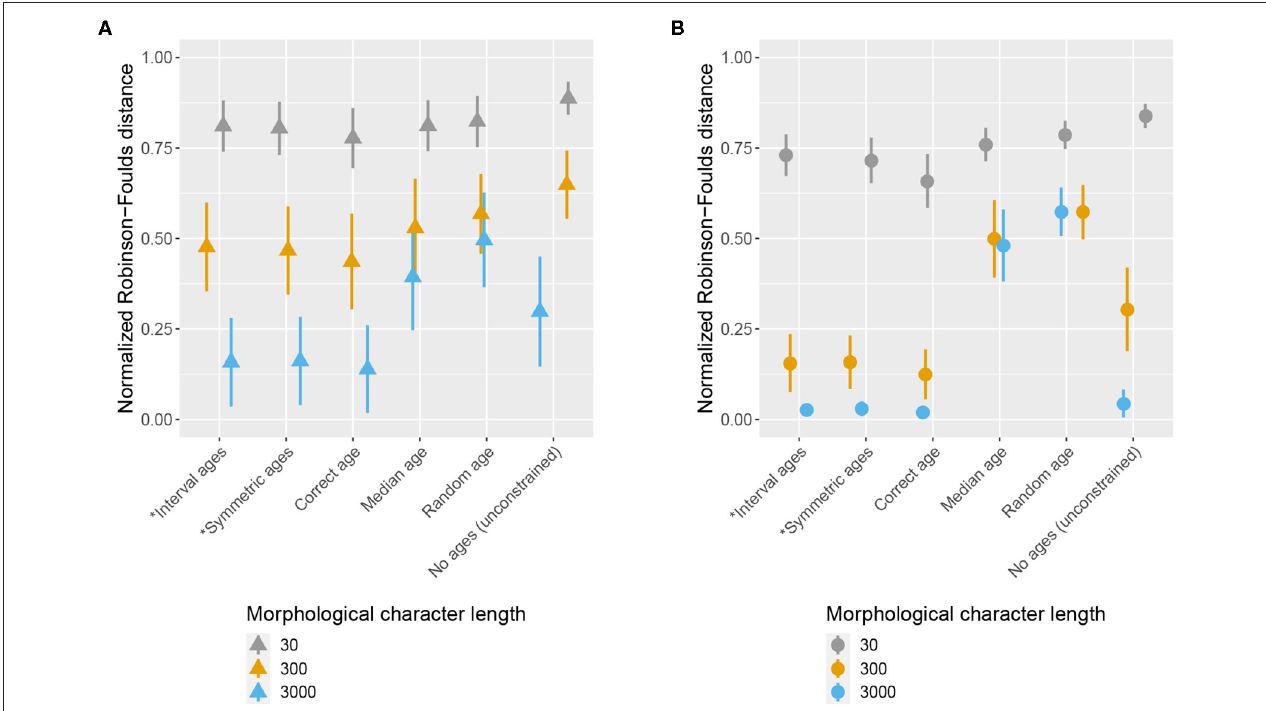
FIGURE 5 | Impact of character and fossil sampling on topology. The mean and standard deviation of the normalized Robinson-Foulds distance between the true simulated tree and trees inferred during MCMC across all replicates are shown for shown for different age handling methods, different character sampling, and different fossil sampling settings [low (A) vs. high (B) ]. Ages sampled as part of the MCMC are marked by (*). (A) Low fossil sampling, (B) High fossil sampling.